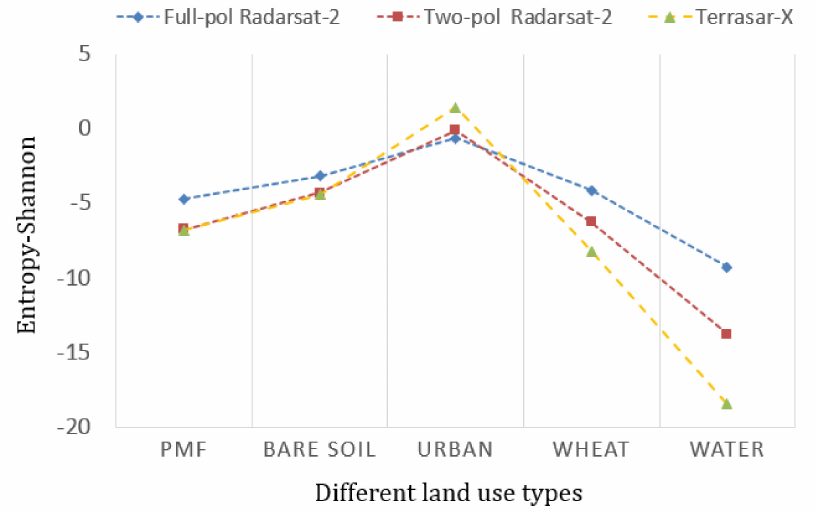
Figure 9. Shannon entropy of all five land cover types calculated from different synthetic aperture radar data (i.e., full-polarimetric RADARSAT-2, dual-polarimetric RADARSAT-2 and dual-polarimetric TerraSAR-X).